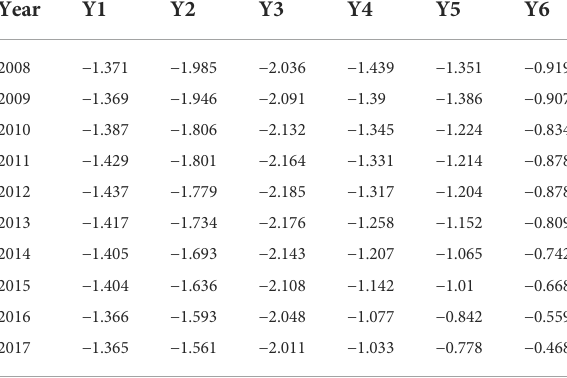
TABLE 4 Relevant data of new variables after Logratio Transformation of component data from 2008 to